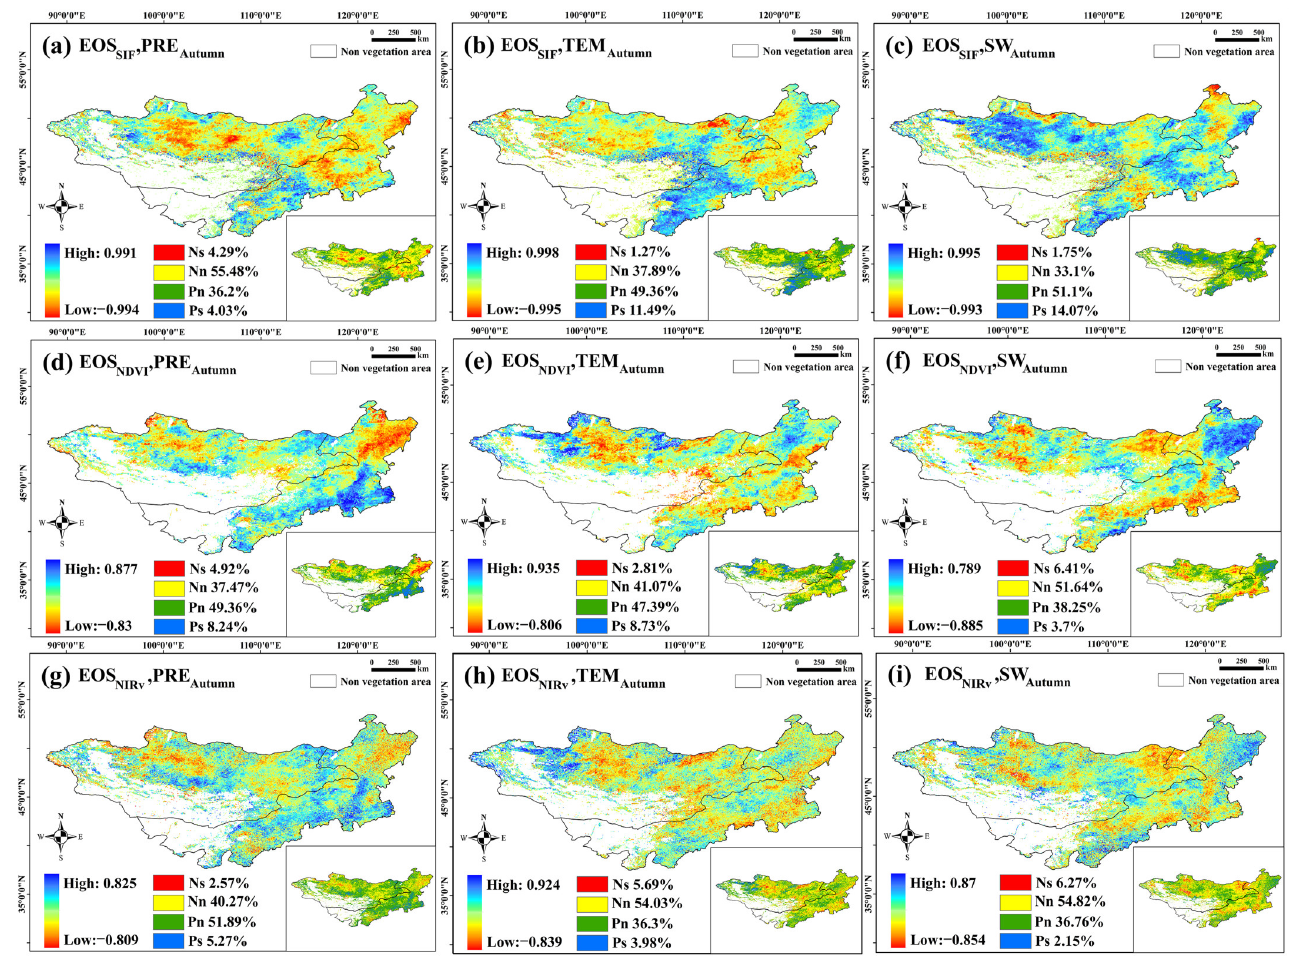
Figure 12. Spatial distributions of the correlations between temperature (TEM Autumn ), precipitation (PRE Autumn ), soil moisture (SW Autumn ) and three types of EOS in (autumn).